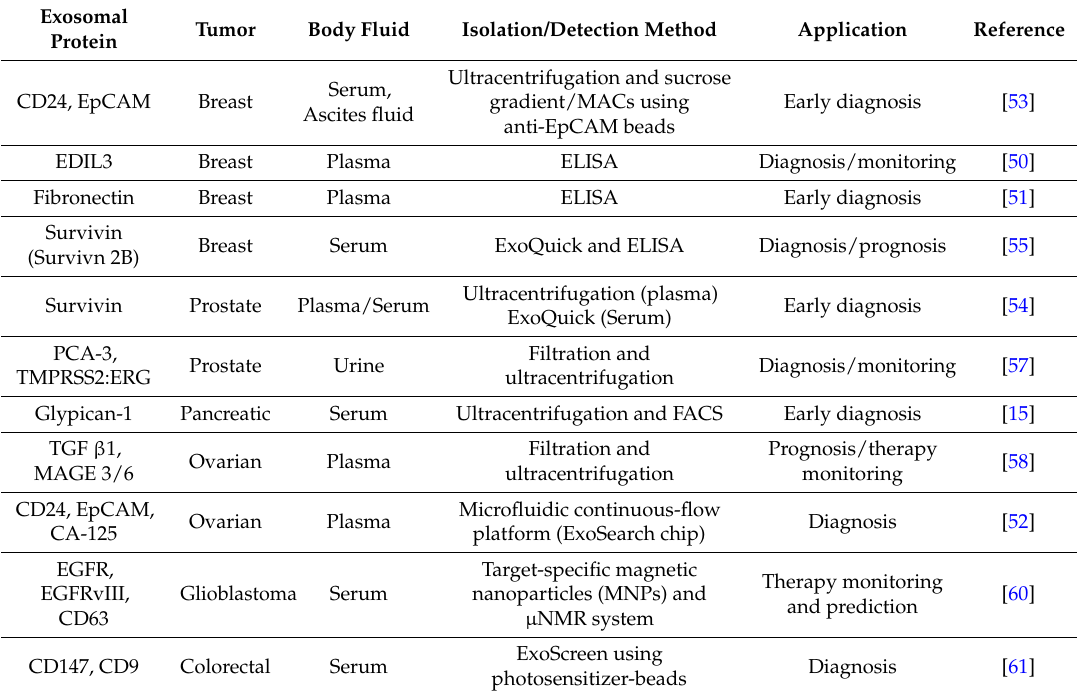
Table 1. Exosomal protein biomarkers from body fluids of patients in pre-clinical and clinical